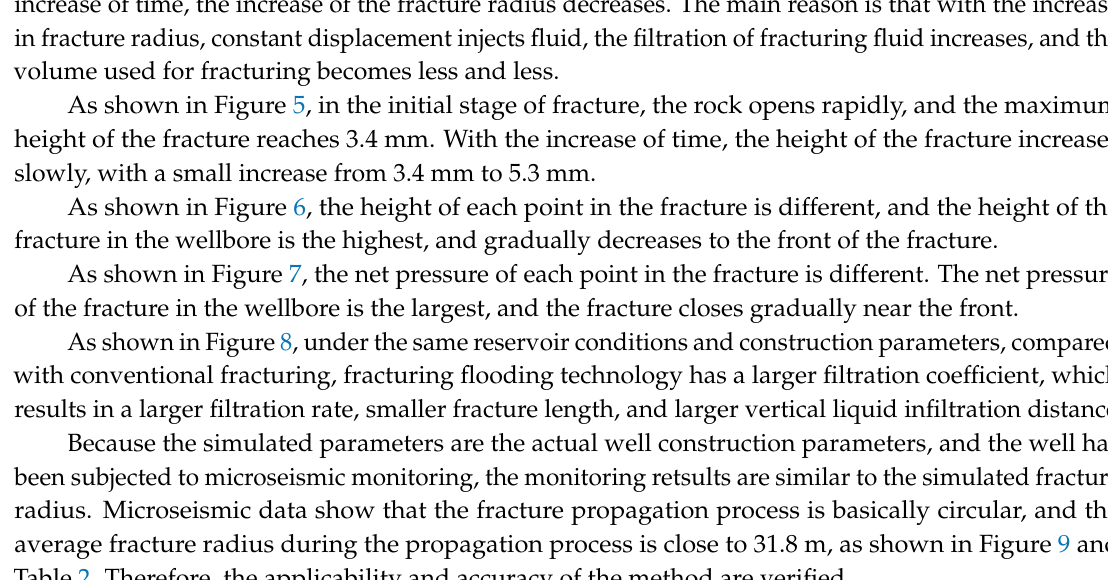
Figure 8. Comparison curves between conventional fracturing and pressure flooding.